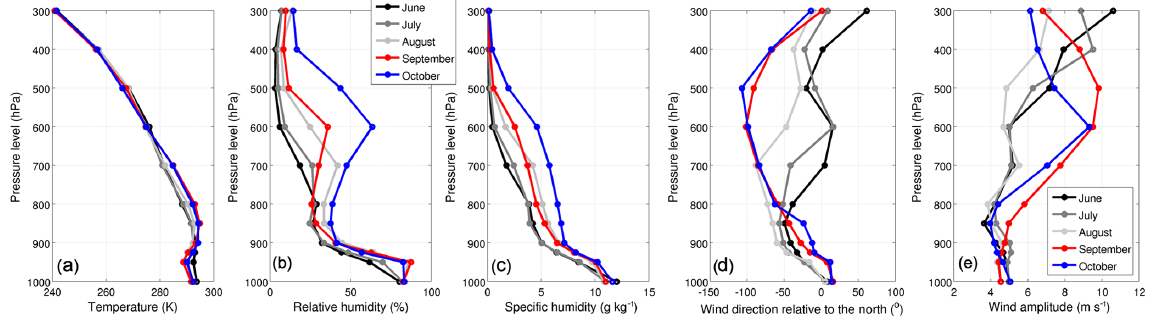
Figure 6. Monthly mean meteorological parameters computed with ERA-Interim models at 12h UTC, from June to October 2008, over the sample area: (a) temperature (K); (b) relative humidity (%); (c) specific humidity (gkg − 1 ); (d) wind direction relative to the north ( ◦ ); (e) wind amplitude (ms − 1 ).